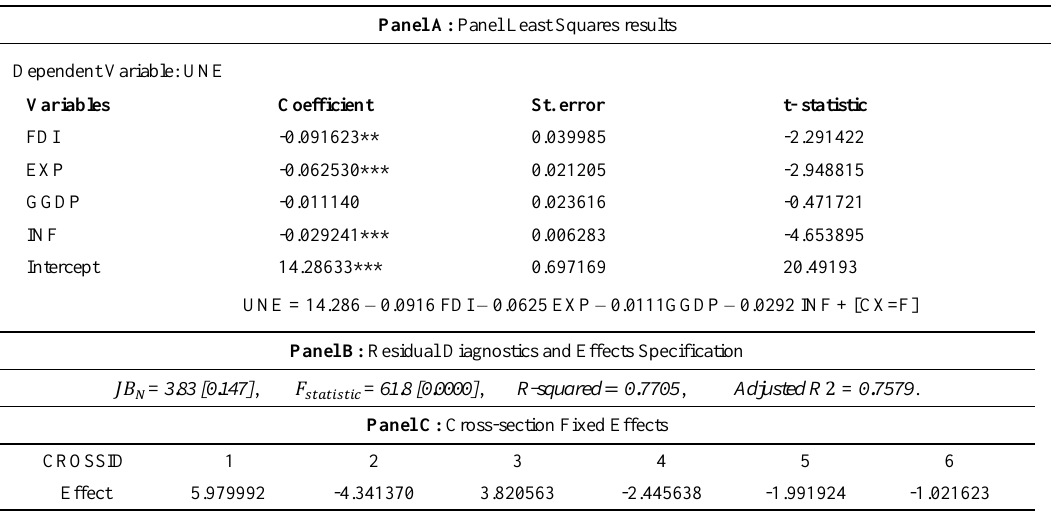
Table 6. Fixed Effect Model (FEM) estimation and test results. Panel A: Panel Least Squares